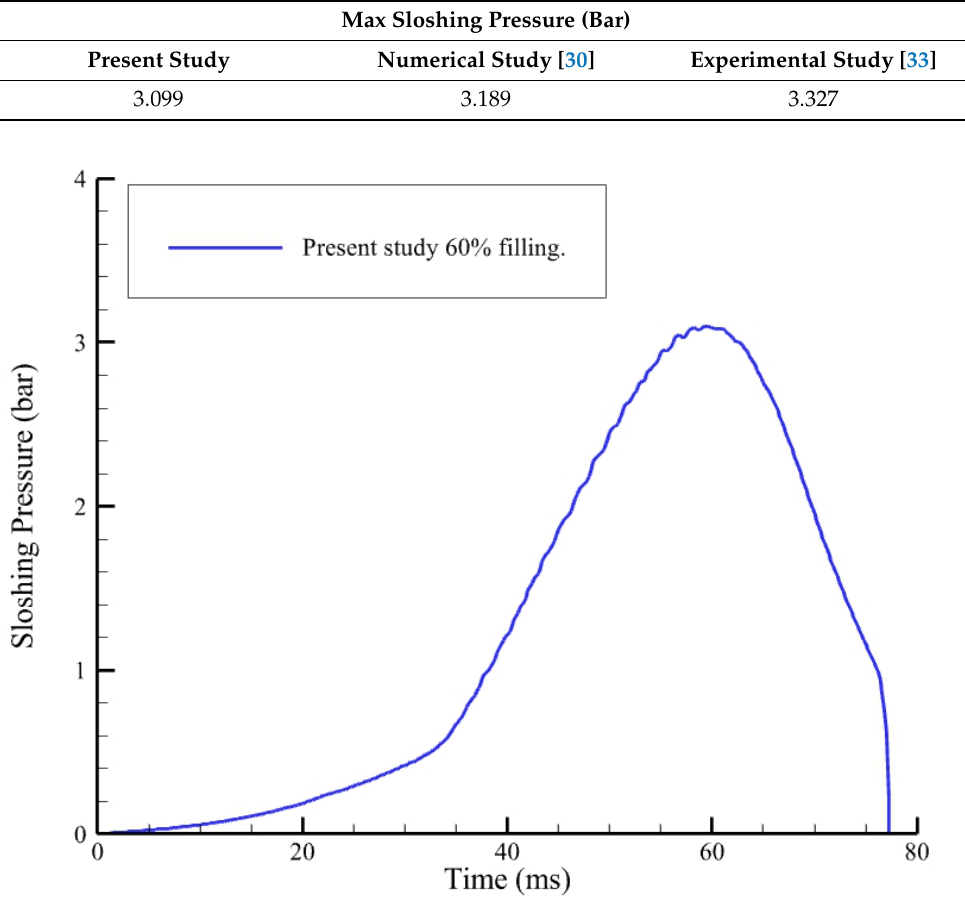
Figure 5. Sloshing pressure results for the case of unbaffled rectangular tank under 60% filling Figure 5. Comparison of the sloshing pressure results in the case of unbaffled rectangular tank un- der 60% filling ratio.